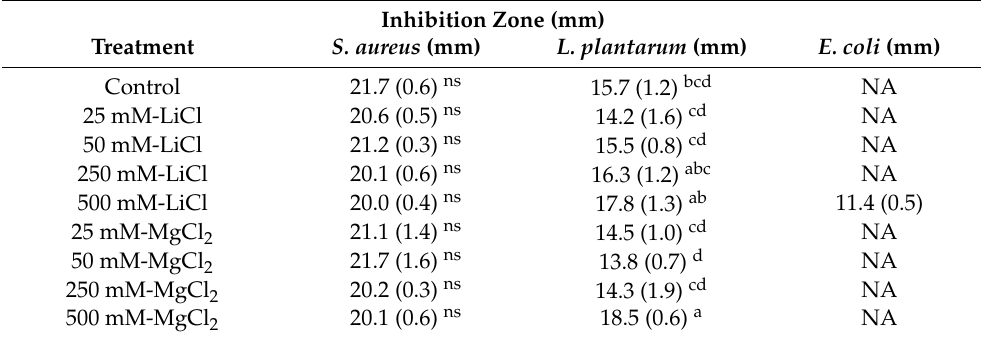
Table 2. Inhibition zones (mm) of MC-films containing Nisin-Z and LiCl/MgCl 2 when evaluated against S. aureus , L. plantarum and E. coli on BHI solid